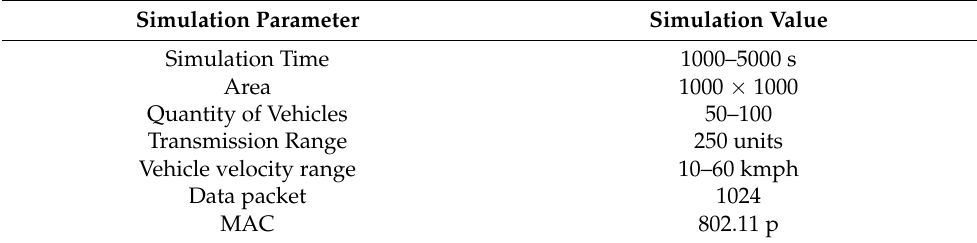
Table 2. Simulation Parameters.